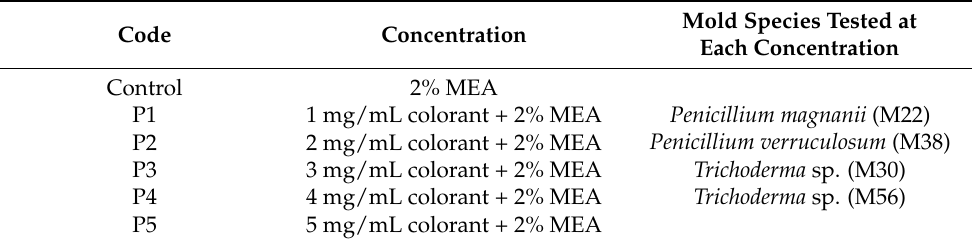
Table 1. Treatments with five concentrations of colorants from Penicillium murcianum and Talaromy- ces australis incorporated in 2% MEA.